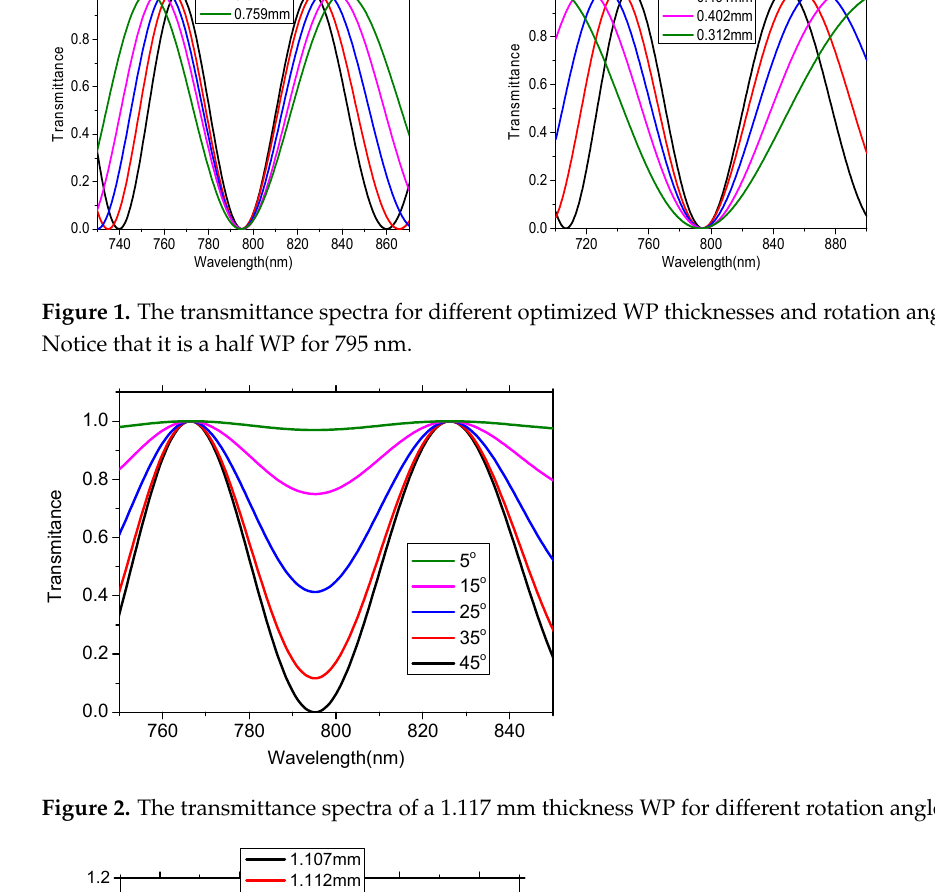
Figure 1. The transmittance spectra for different optimized WP thicknesses and rotation angle of 45°. Notice that it is a half WP for 795 nm.